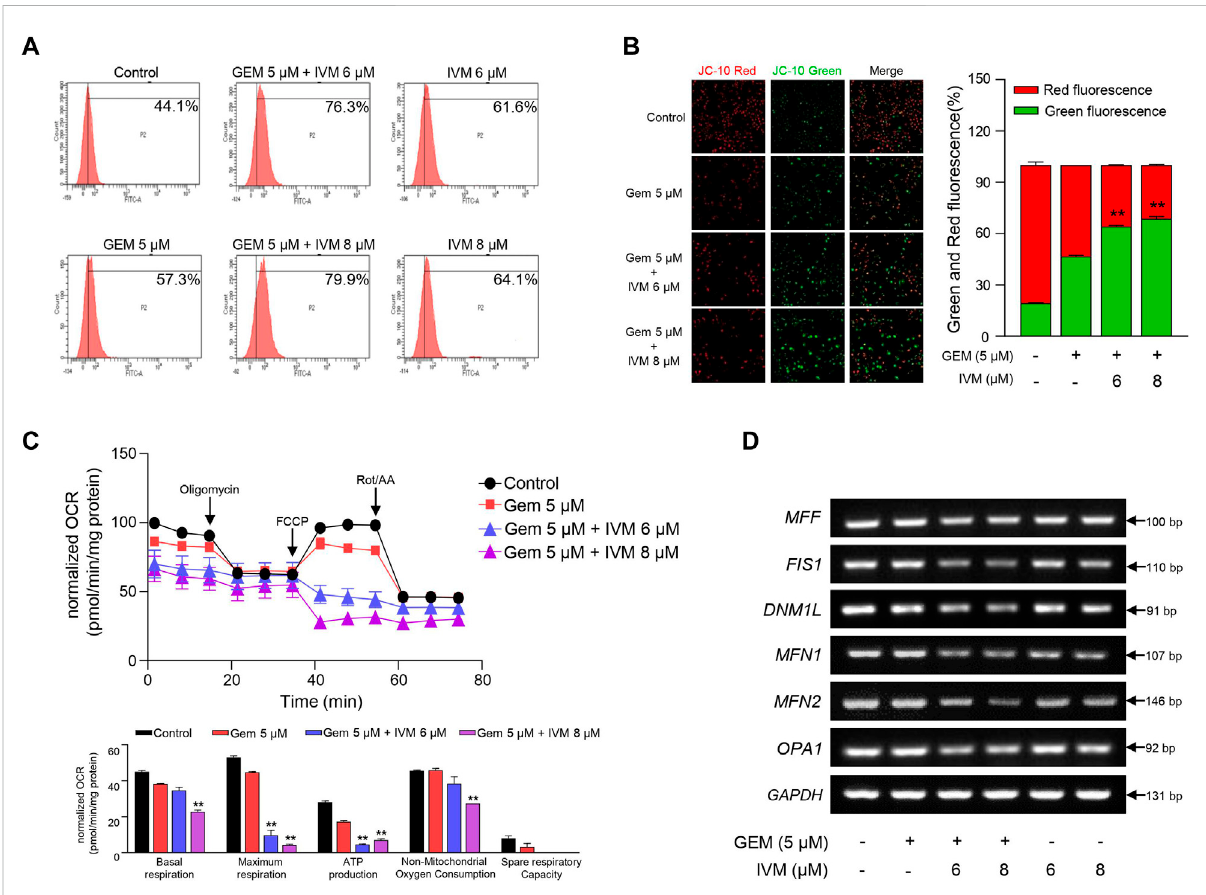
FIGURE 4 Combination of ivermectin and gemcitabine induces mitochondrial dysfunction via reactive oxygen species (ROS) generation. (A) Relative ROS productioninMIAPaCa-2cellstreatedwithgemcitabineandivermectinwasanalyzedusing fl owcytometryafterdichloro fl uorescein(DCF)-staining. (B) After JC-10 staining, mitochondrial membranepotential (MMP) was measured via fl uorescence microscopy. Data represents themean ± SD ( n = 3). * p < 0.05 and ** p < 0.01 compared with the gemcitabine alone group. (C) Oxygen consumption rate (OCR) was determined after treatment with ivermectin and gemcitabine and calculated under oligomycin, carbonyl cyanide p-(tri fl uoromethoxy) phenylhydrazone (FCCP), and Rot/ antimycin A treatments. Data represents the mean ± SD ( n = 3). * p < 0.05 and ** p < 0.01 compared with the gemcitabine alone group. (D) mRNA expression levels of mitochondria fusion and fi ssion genes were determined via